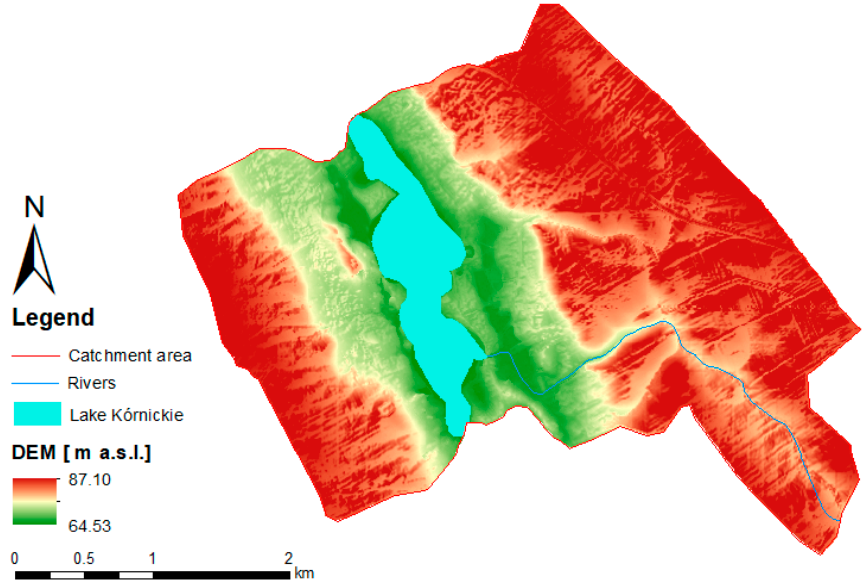
Figure 3. Digital elevation model of the catchment area of Lake Kórnickie.